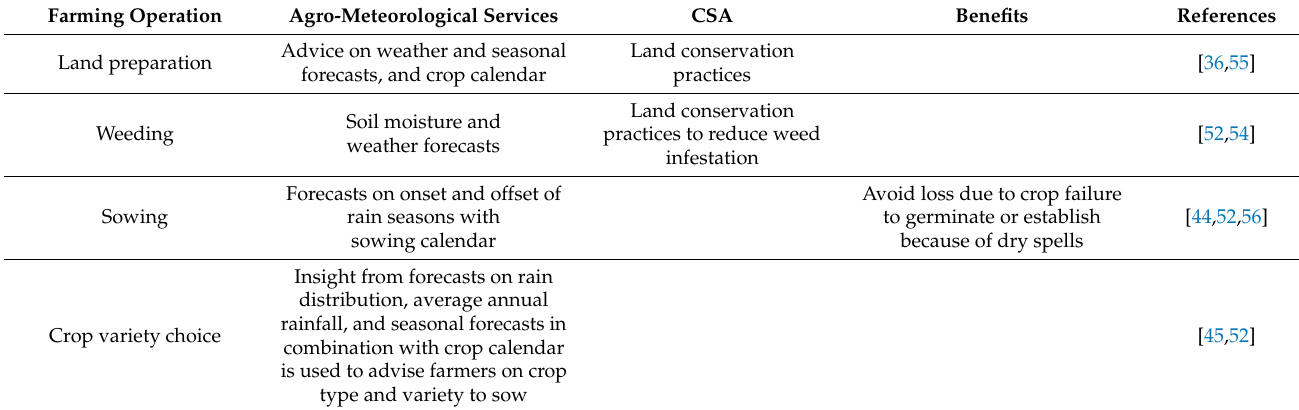
Table 3. Commonly used agrometeorological